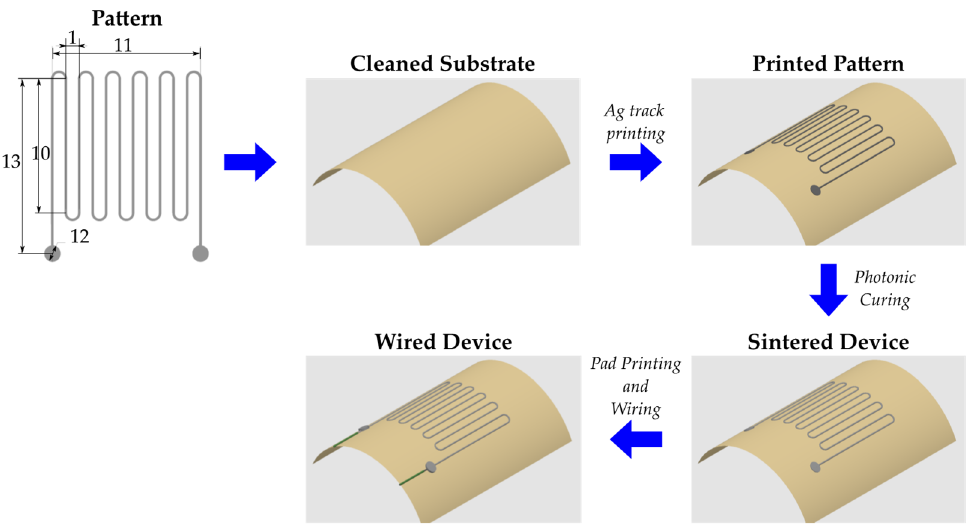
Figure 5. Diagram of the circuit manufacturing steps: (1) Preparation of the 2D model of the printed device with serpentine pattern (in mm); (2) Cleaning of the surface with solvent to remove dust and dirt; (3) Deposition of Ag ink with Aerosol Jet Printing (AJP) according to the 3D model and drying at room temperature; (4) Curing of the resulting device with Flash Lamp Annealing (FLA) (5) Deposition of epoxy conductive paste to fix the wires and create the electrical contacts with the deposited ink.